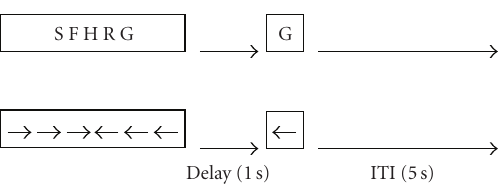
Figure 1: Trial sequence in the working memory (letters) and control (arrows) conditions. Three consecutive working memory trials alternated with three consecutive control trials. ITI = intertrial